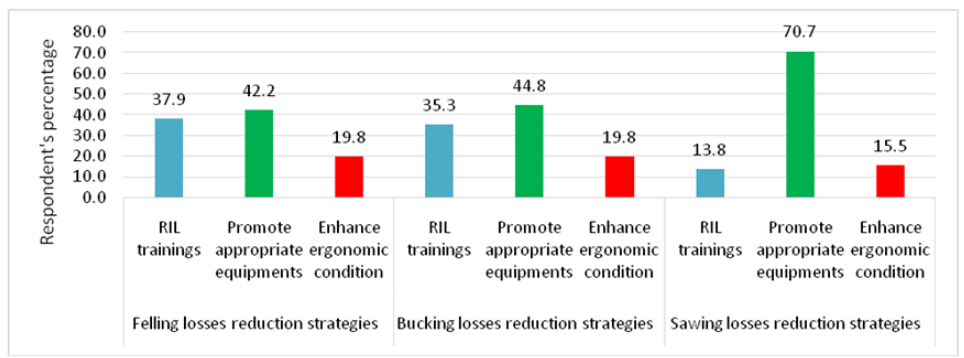
Figure 6. Bar graph showing major strategies suggested by the forest experts in order to reduce the timber losses along with the different stages of the timber harvesting process. timber losses along with the different stages of the timber harvesting